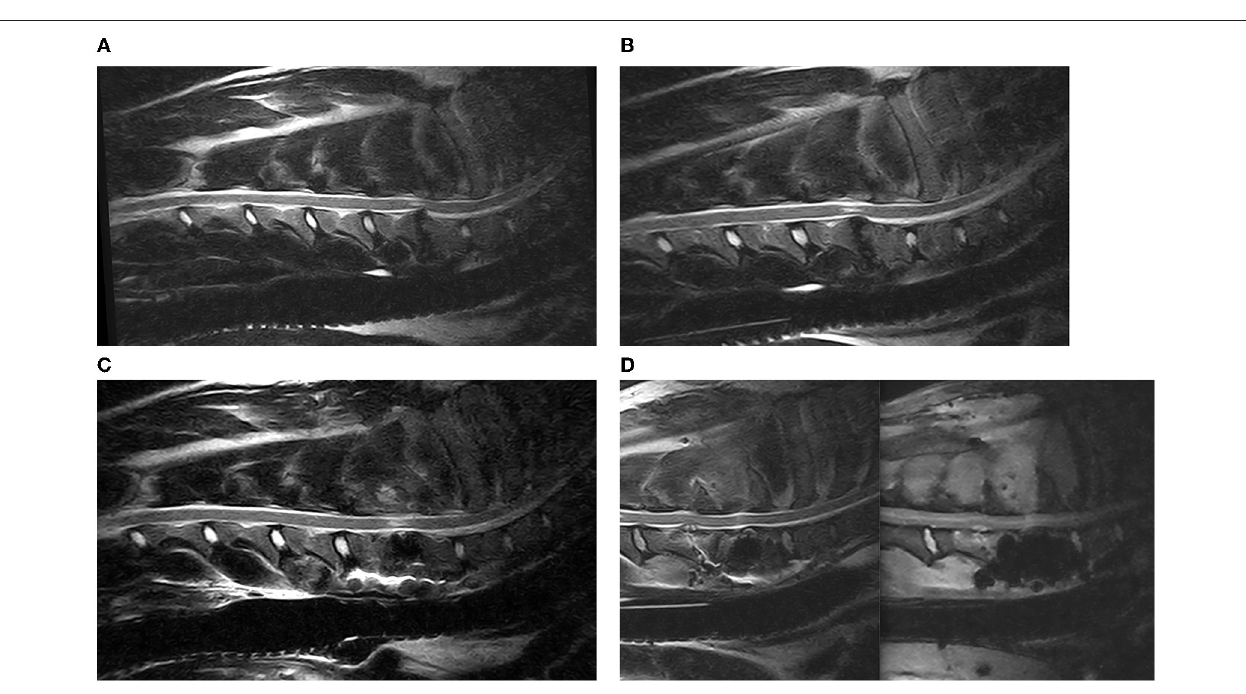
FIGURE 6 | Sagittal T2 weighted images of a DA-CSM-dog, pre- (A) and post-traction (B) and 3 months post DS-surgery (C) ; from left to right sagittal T2 Weighted and STIR Images of an example of discospondylitis at C5–C6, in a patient previously treated by DS at C6–C7 (D)